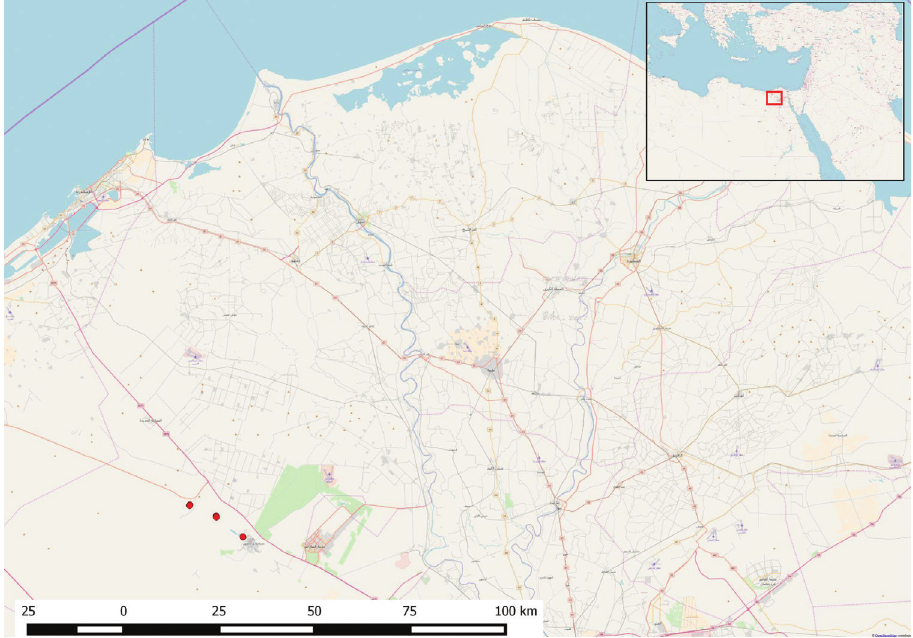
Figure 8. Geographic range and distribution map of Typha elephantina in